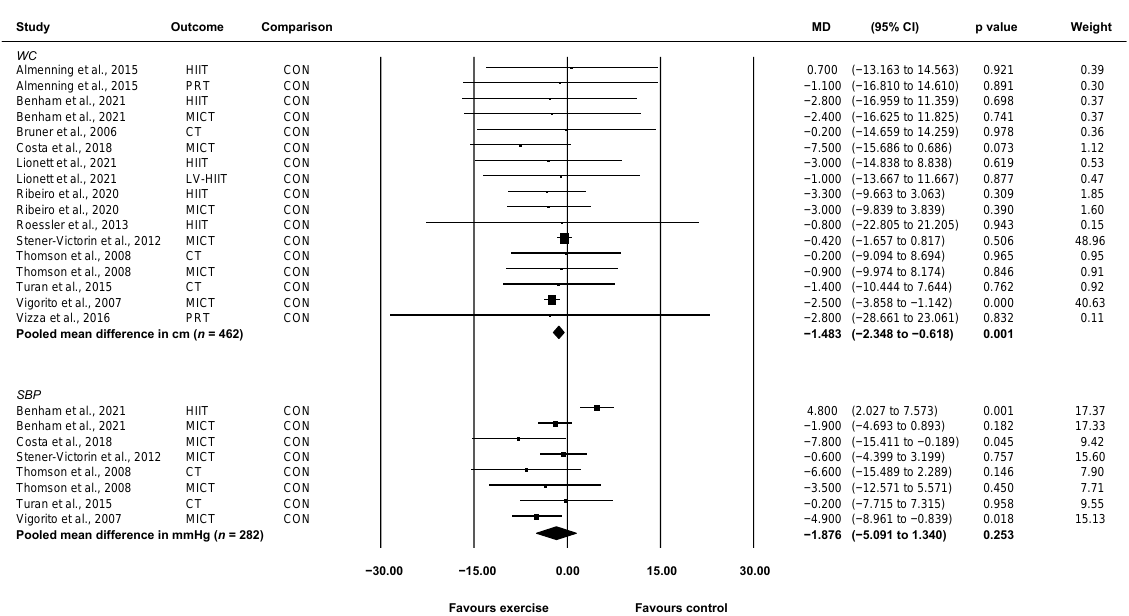
Figure 4. Effect of exercise vs. control for change in waist circumference and systolic blood pressure. CI: confidence interval, CT: concurrent training, HIIT: high-intensity interval training, LV-HIIT: low-volume high-intensity interval training, MD: mean difference, MICT: moderate-intensity continuous training, PRT: progressive resistance training, SBP: systolic blood pressure, WC: waist circumference.